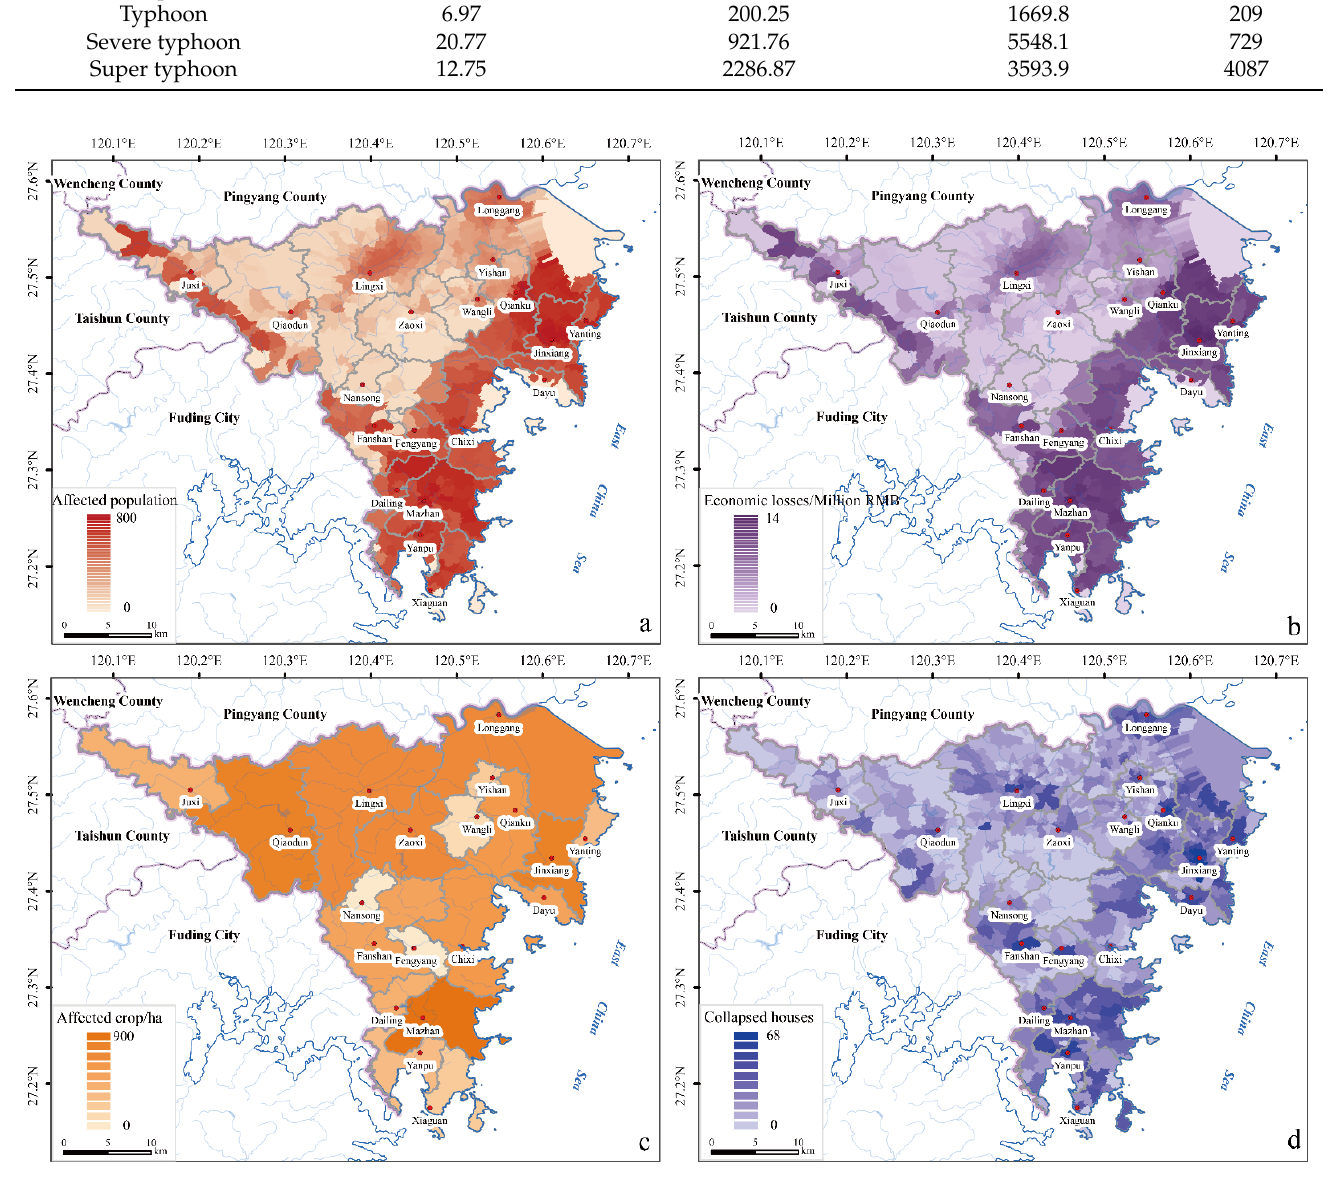
Figure 4. Spatial patterns of super typhoon risk in Cangnan County: ( a ) population, ( b ) economy, ( c ) crops, and ( d ) houses.